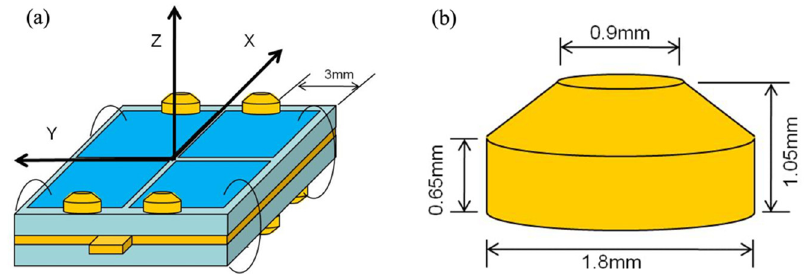
Figure 8. ( a ) Bimorph stator and ( b ) the friction tip